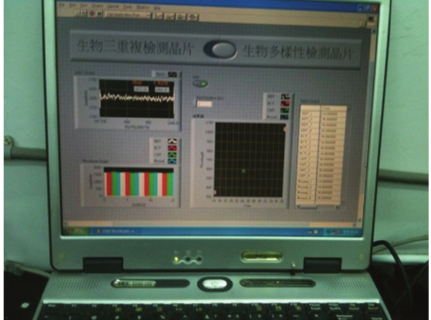
Figure 9: User interface for the automated control system.